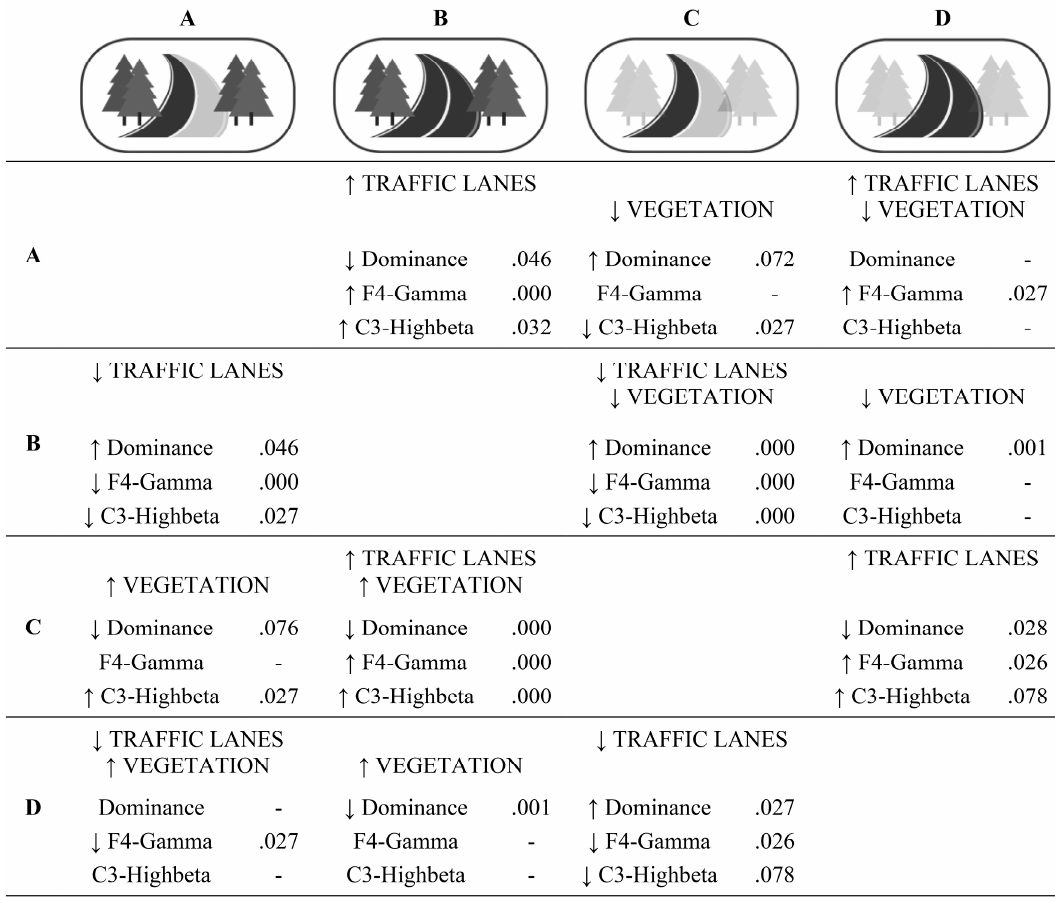
Figure 5. Effect on the metrics of the possible interventions for each of the daytime scenarios. Figure 5. E ff ect on the metrics of the possible interventions for each of the daytime